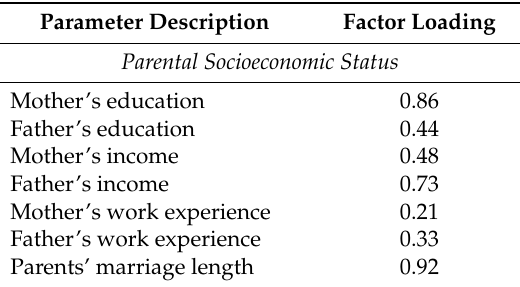
Table 7. Factor loading analysis of research latent